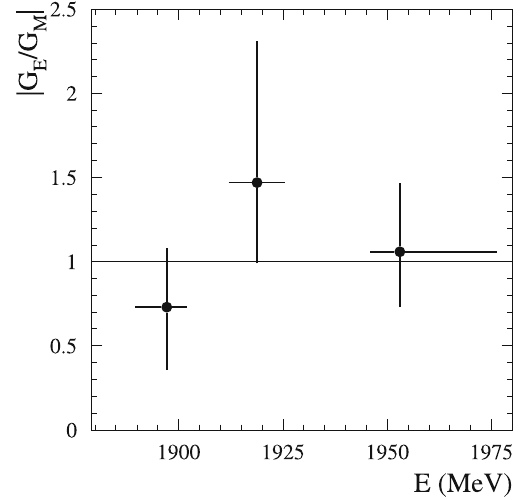
Fig. 9 The energy dependence of the detection efficiency for e + e − → n ¯ n events determined using MC simulation for the 2017 (circles) and 2019 (triangles) runs. The left edge of the plot corresponds to the n ¯ n